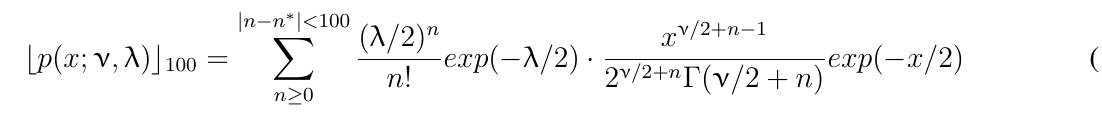
Algorithm 1. The difference between the actual maximum and (cid:98) λ / 2 (cid:99) is quite stark outside the HDR. Also shown are the Laplace approximate upper (Ub) and lower bounds (Lb) associated with B = 4 used for Algorithm